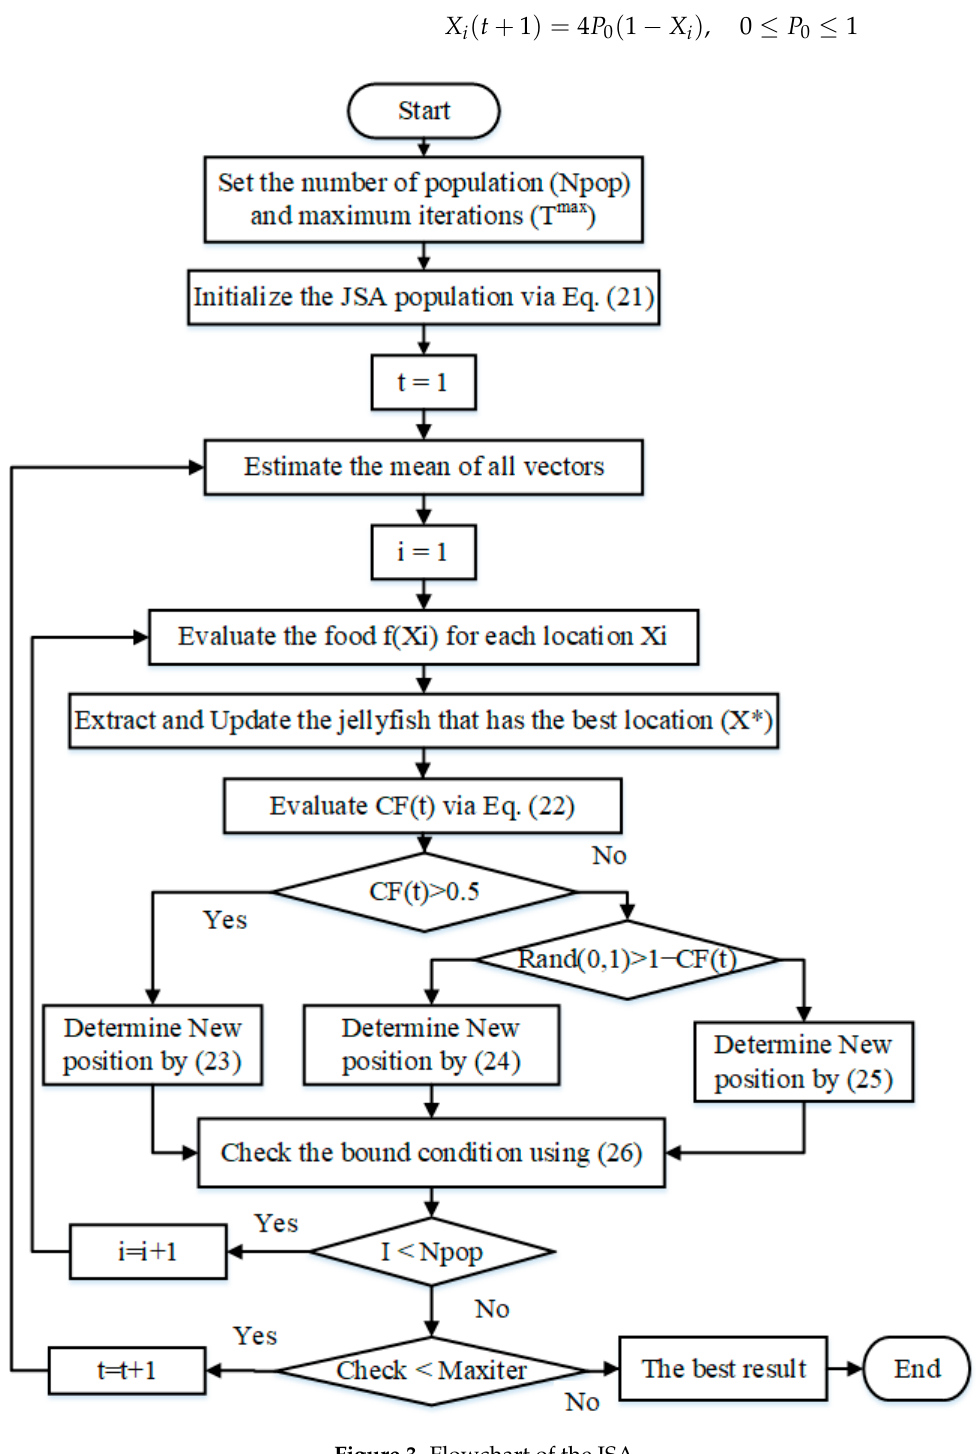
Figure 3. Flowchart of the JSA.